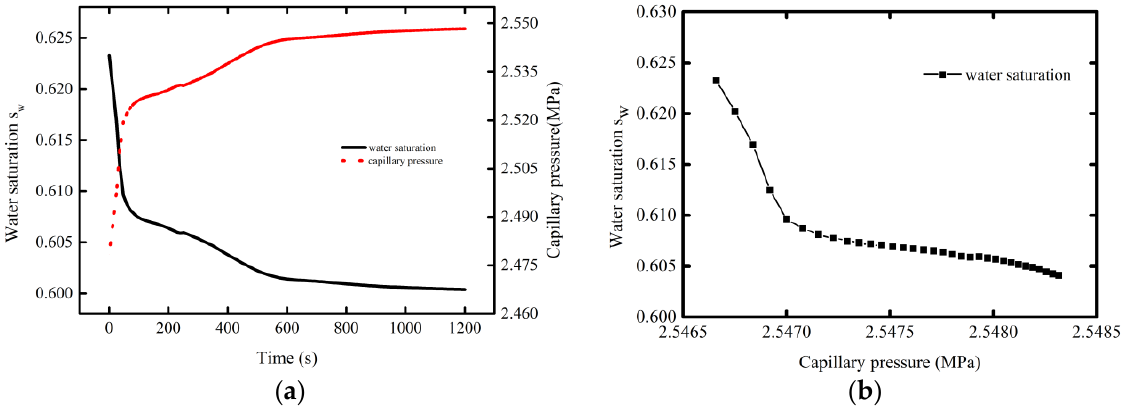
Figure 8. Evolution curve of the water saturation and capillary pressure at observation point E (0.005 m, 0.0125 m). ( a ) The change in water saturation and ( b ) change in water saturation capillary pressure over time with capillary pressure.